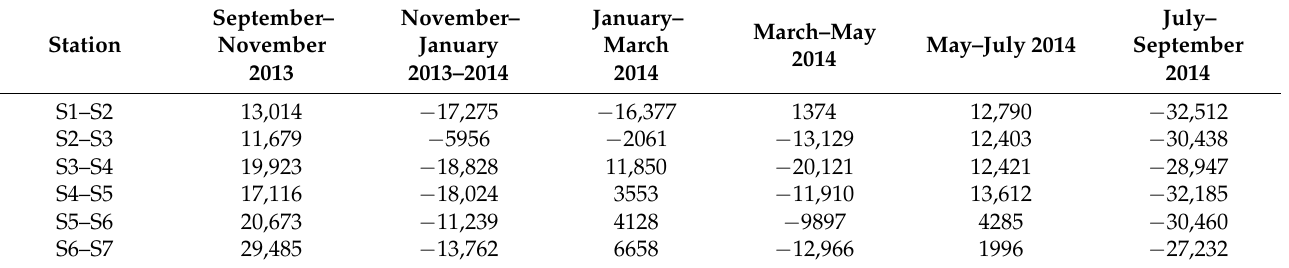
Table 4. Net sediment volume in m 3 registered among the